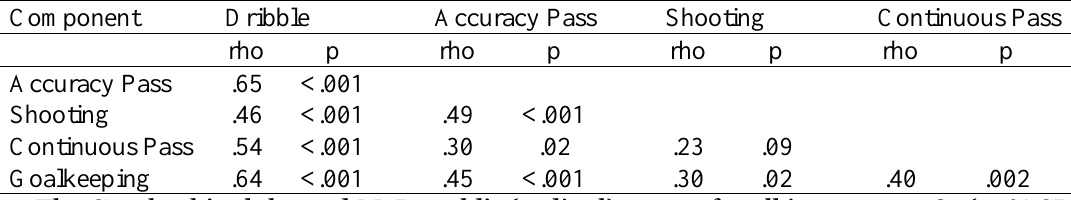
Table 4. Quartile score spearman correlation